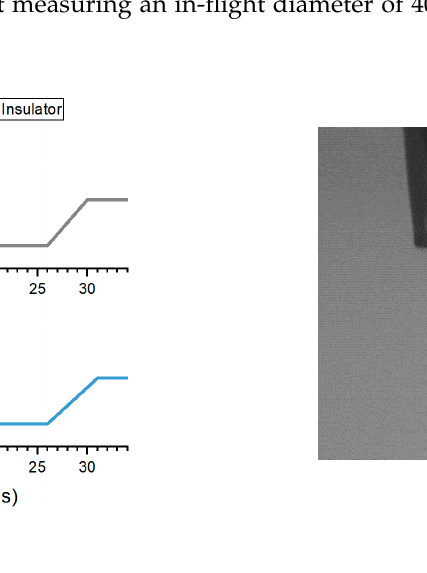
Figure 1. ( a ) Illustration of the waveform used to print both inks using a 60 µm printhead heated at 40 °C; ( b ) a snapshot of the droplet measuring an in-flight diameter between 40–45 µm. A drop-on-demand inkjet printer (Jetlab-4XL, from MicroFab Technologies Inc., Plano, TX, USA) with a 60 µ m nozzle was used. The insulator layer was printed with a droplet spacing of 30 µ m, while the silver nanoparticle layer was printed on the insulator with a droplet spacing of 80 µ m with two layers to ensure an even smooth coverage and